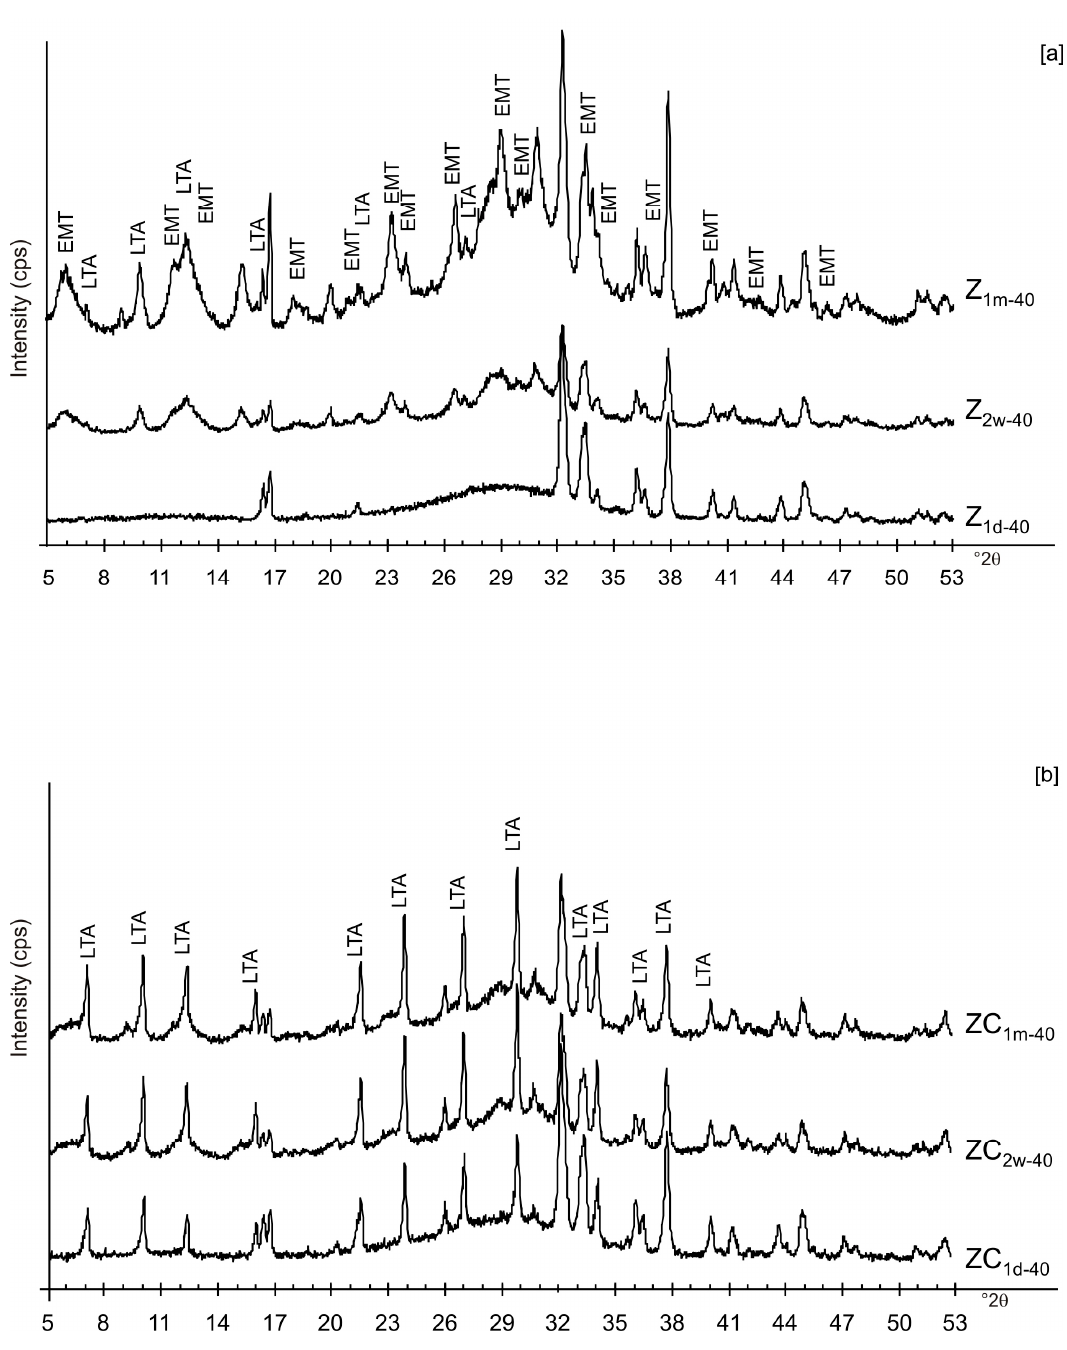
Figure 9. X-ray diffraction profiles of Z ( a ) and ZC ( b ) dried at 40 °C. Figure 9. X-ray di ff raction profiles of Z ( a ) and ZC ( b ) dried at 40 ◦